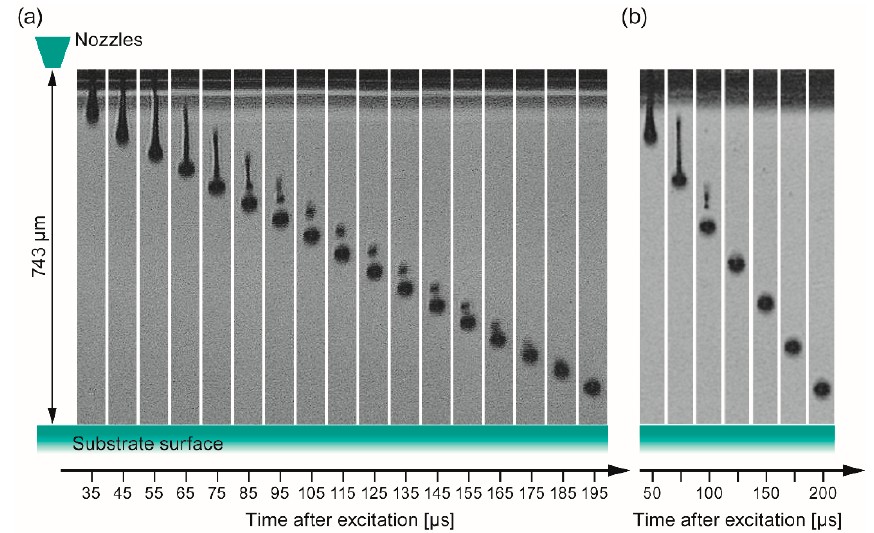
Figure 8. Jetting analysis of the two different inks obtained by dilution of the stock solutions with propionic acid (1:1 vol. ratio) as a function of the elapsed time after triggering the piezoelectric actuator of the nozzle. ( a ) Ink- 1 (c = 0.15 mol/L, derived from con -BZY10); ( b ) Ink- 2 (c = 0.075 mol/L, derived from µE -BZY10). Note, preliminary experiments with methanol as dilution solvent for µE -BZY10 did not lead to a reproducible jetting behavior, most likely due to the combination of a low boiling point (i.e., high vapor pressure) and low surface tension of methanol (22.5 mN/m @ 22 °C).